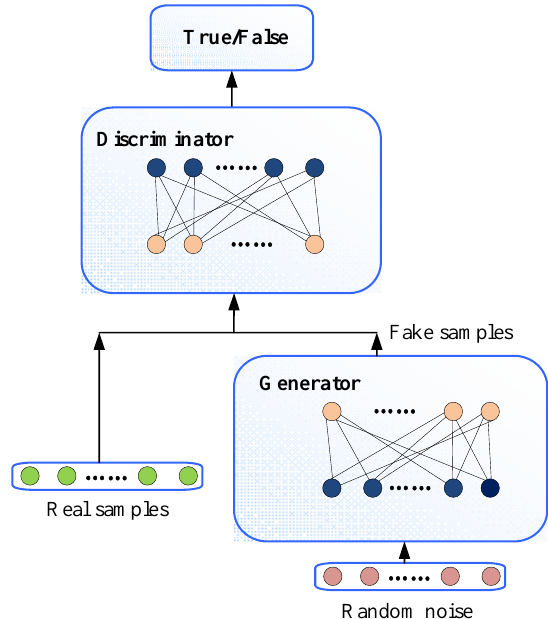
Figure 2. Schematic diagram of the basic process of GAN.